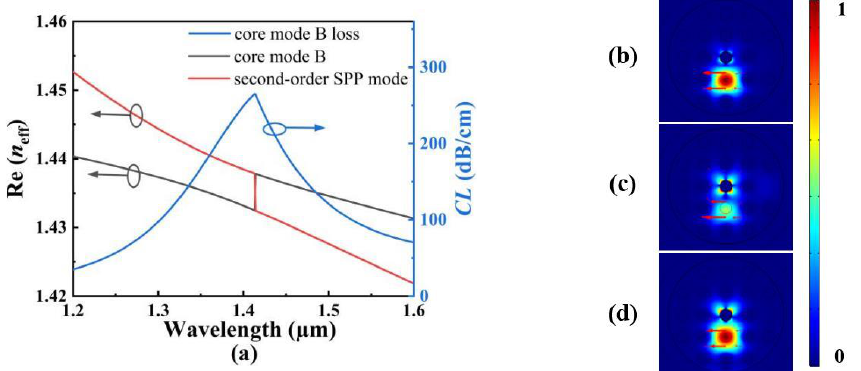
Figure 3. ( a ) The CL spectra of the core mode B, and the effective RI real parts of the core mode B and second-order SPP mode when the temperature is chosen as 20 °C. ( b – d ) show the mode field distributions of the core mode B and the second-order SPP mode calculated at wavelengths 1.3, 1.414, and 1.5 μm, respectively.